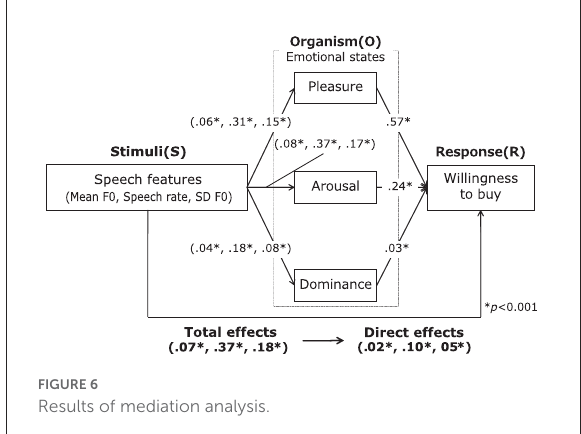
FIGURE6 Results of mediation analysis.